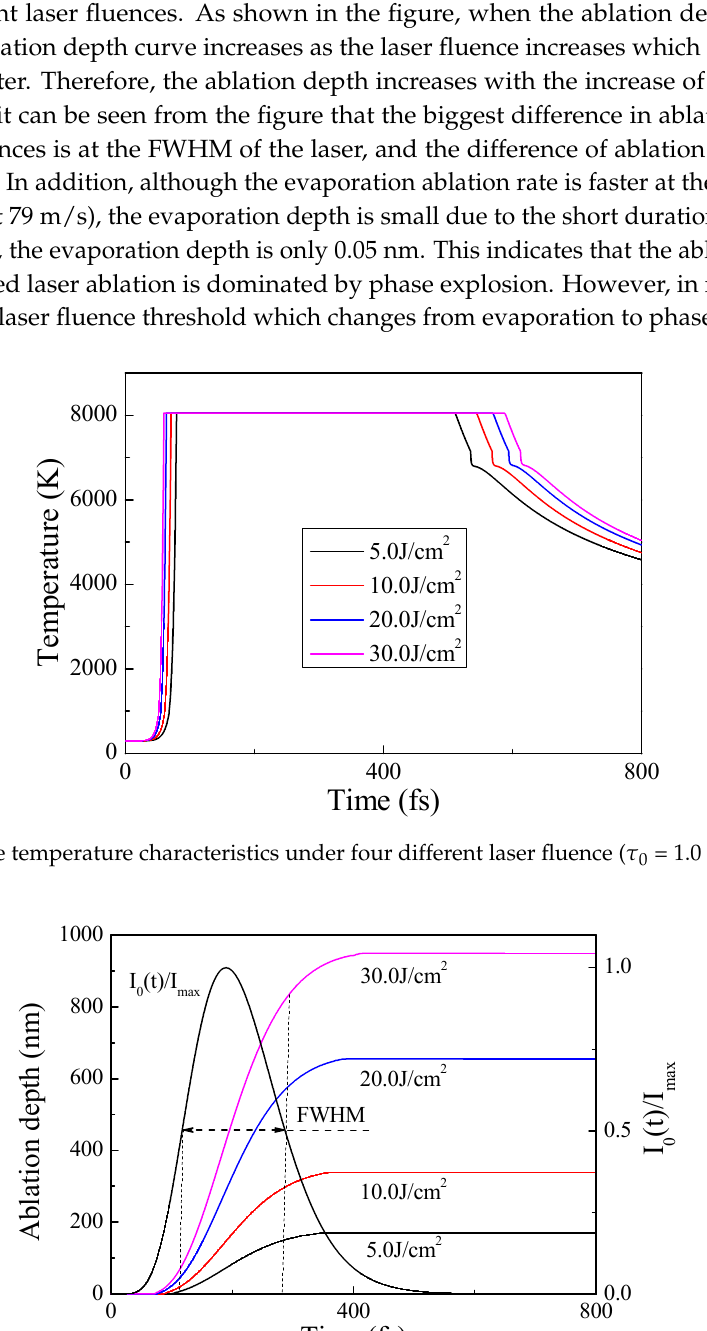
Figure 8. The ablation depths vary with time under four different laser fluence ( τ 0 = 1.0 × 10 − 13 s).